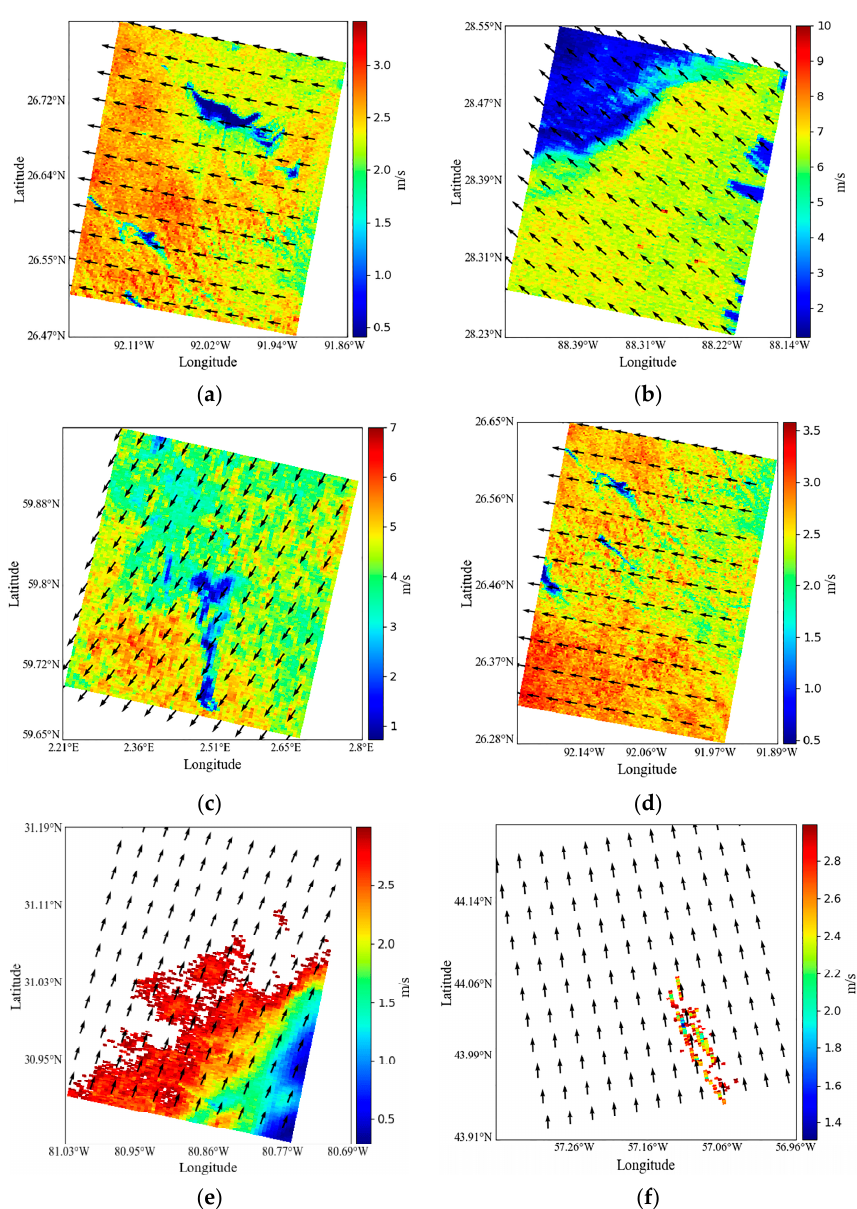
Figure 8. SAR wind field inversion results, ( a – f ) are Cases 1–6, respectively. In Cases 5 and 6, the area with wind speeds above 3 m/s is white.